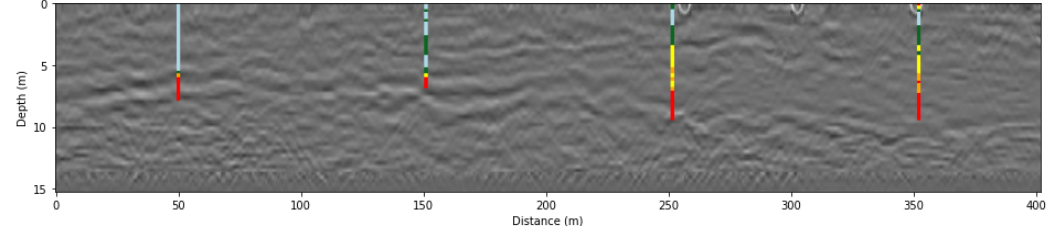
Figure 11. Another example of a GPR track augmented with exploration hole data. The exploration holes are coloured by relative SiO 2 values. From low to high percentages, SiO 2 is coloured as: light blue, green, yellow, orange, and red.